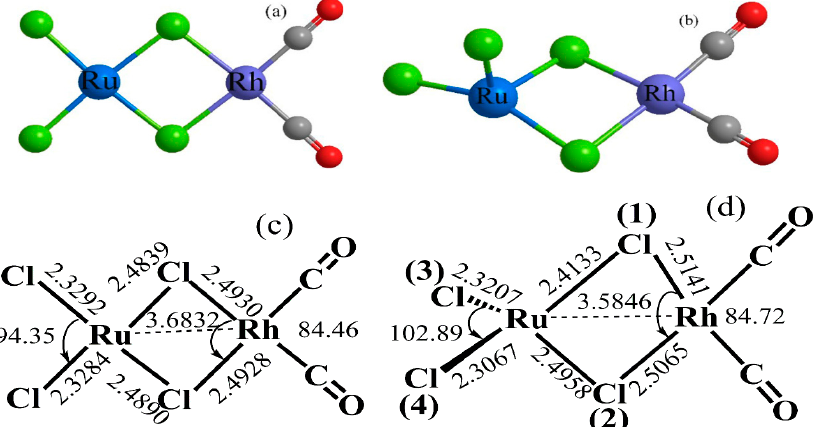
Figure 2. Geometric structure of Rh(I)/Ru(III) bimetallic catalysts: ( a , c ) plane structure of Rh(I)/Ru(III) bimetallic catalysts; ( b , d ) stereo structure of Rh(I)/Ru(III) bimetallic catalysts (bond length in Å, bond angle in degrees).